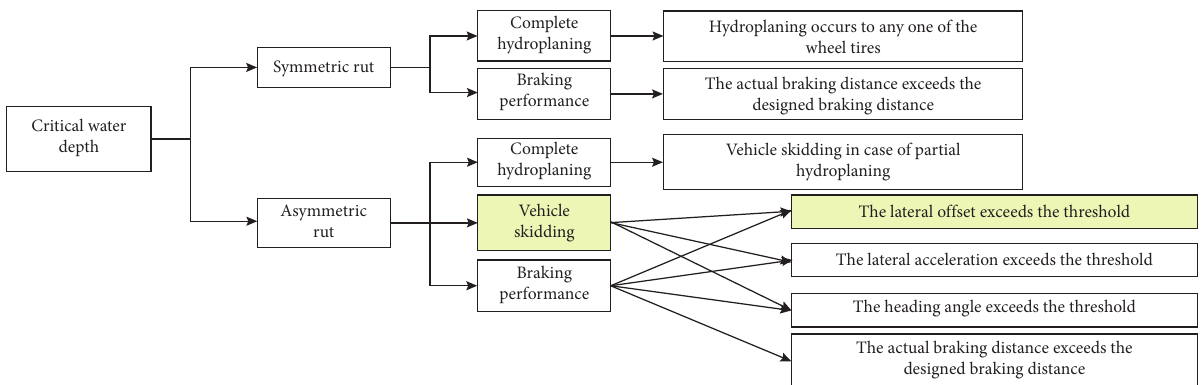
Figure 3: Impact of 3-dimensional ruts on driving safety.